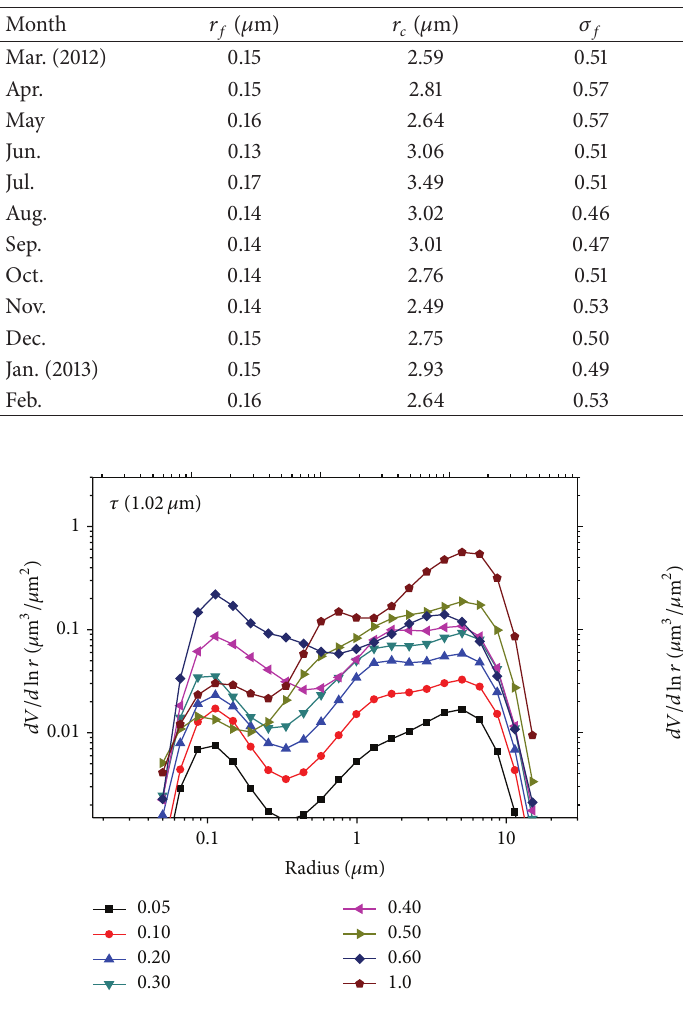
Figure 6: The size distribution of dust aerosol is divided into eight categories in terms of AODs ( 𝜏 ≤ 0.05 , 0.05 < 𝜏 ≤ 0.1 , 0.1 < 𝜏 ≤ 0.2 , 0.2 < 𝜏 ≤ 0.3